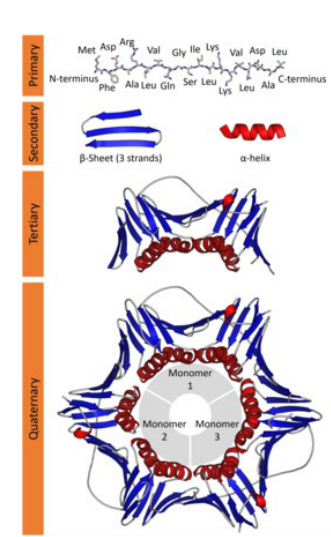
Figure 2 . Proposed